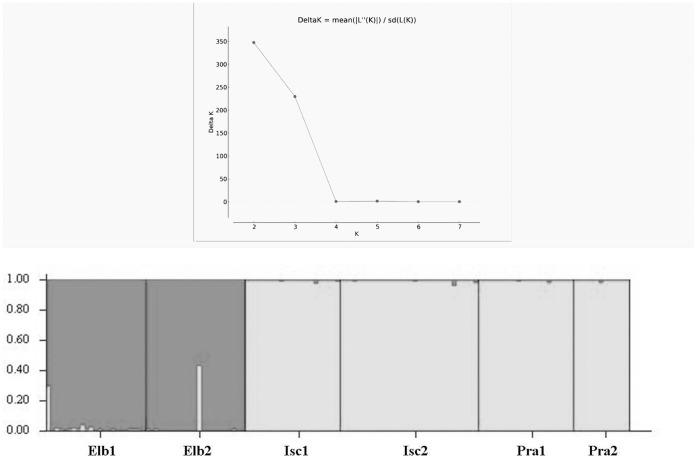
Above, values of ΔK, calculated as in [50] and based on the log likelihood of the data given by STRUCTURE for each number of clusters assumed (K).Below, results of the clustering analysis. In the bar plot, each of the individuals is represented by a vertical bar indicating its estimated proportion of membership to each cluster (represented by different colours).